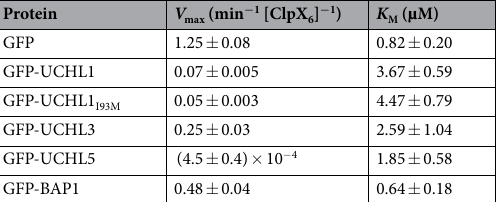
Table 2. Michaelis-Menten analysis of GFP-UCHs. The reported mean values and standard deviations were derived from three independent measurements.